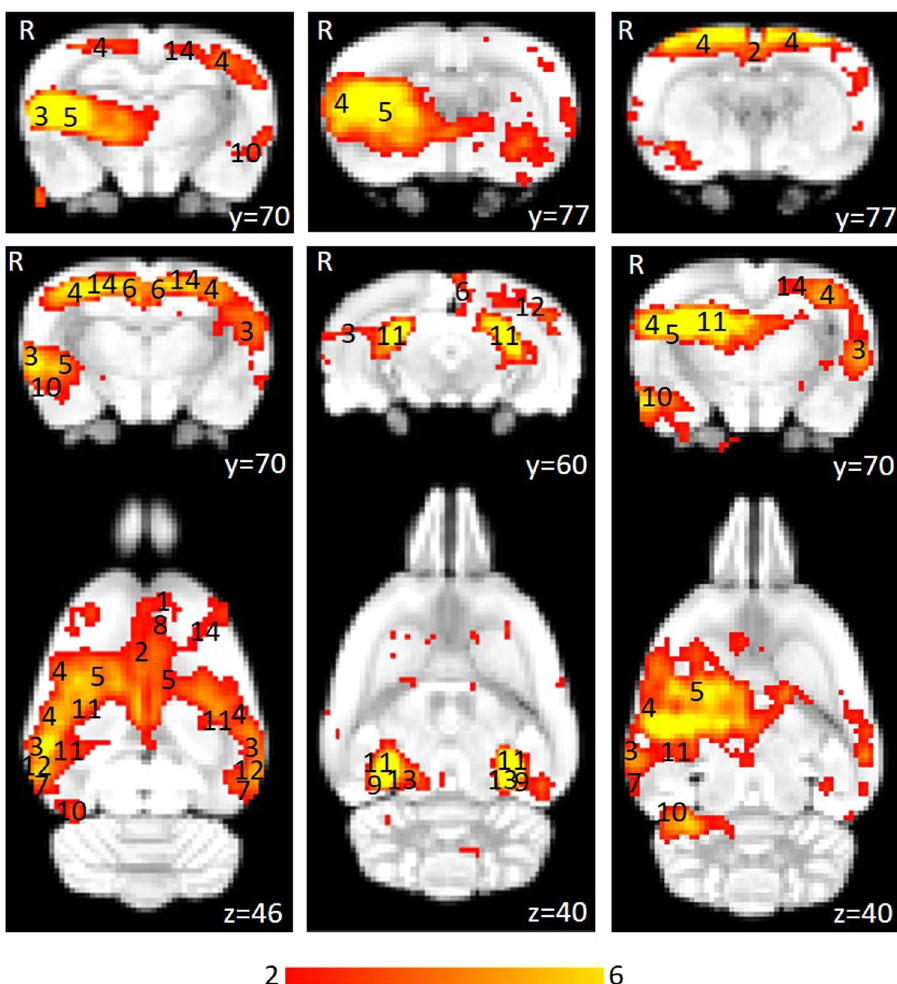
Figure 3. Thresholded independent component spatial maps showing the resting-state network in the pre- stimulation rs-fMRI group-ICA dataset. The figure shows six independent components from the group-ICA, three coronal slices and three coronal slices with their corresponding axial slices. The spatial colour-coded z-maps of these components are overlaid on the brain atlas (down-sampled by a factor of eight). A higher z-score (yellow) represents a higher correlation between the time course of that voxel and the mean time course of this component. Significant clusters within the components include various brain regions: 1, orbital cortex; 2, cingulate cortex; 3, auditory cortex; 4, somatosensory cortex; 5, striatum/caudate putamen; 6, retrosplenial cortex; 7, temporal association cortex; 8, prelimbic cortex; 9, parasubiculum; 10, entorhinal cortex; 11, hippocampus; 12, visual cortex; 13, inferior colliculus; 14, motor cortex. R denotes right hemisphere. x, y, z refer to the coordinates in standard Sprague Dawley template space. Colour bar indicates z-scores (n = 24, thresholded at z > 2, uncorrected p-value < 0.0455 for a two-tailed